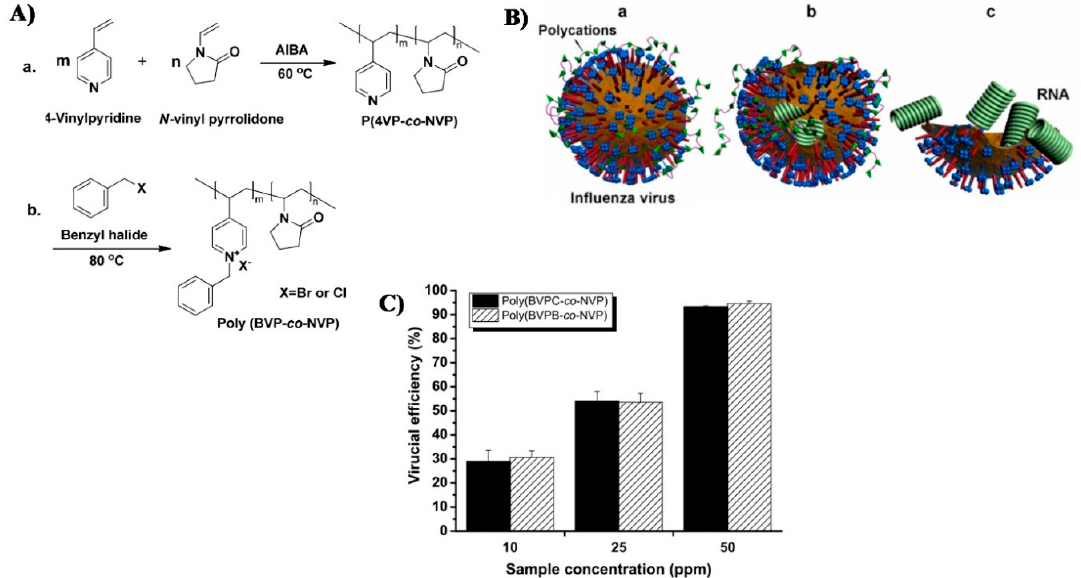
Figure 11. ( A ) The synthesis of the copolymers that were tested by Xiao and Xue; ( B ) The antiviral effect of the quaternary pyridinium containing co-polymers on the Influenza viruses; ( C ) Results of antiviral tests of the two polymers in Influenza viruses, where a is the absorption on the virus’s surface, b is the penetrating of the polymers into the lipid envelope and c is the leakage of the virus’s RNA caused by the damage to the envelope. Based on reference [35].